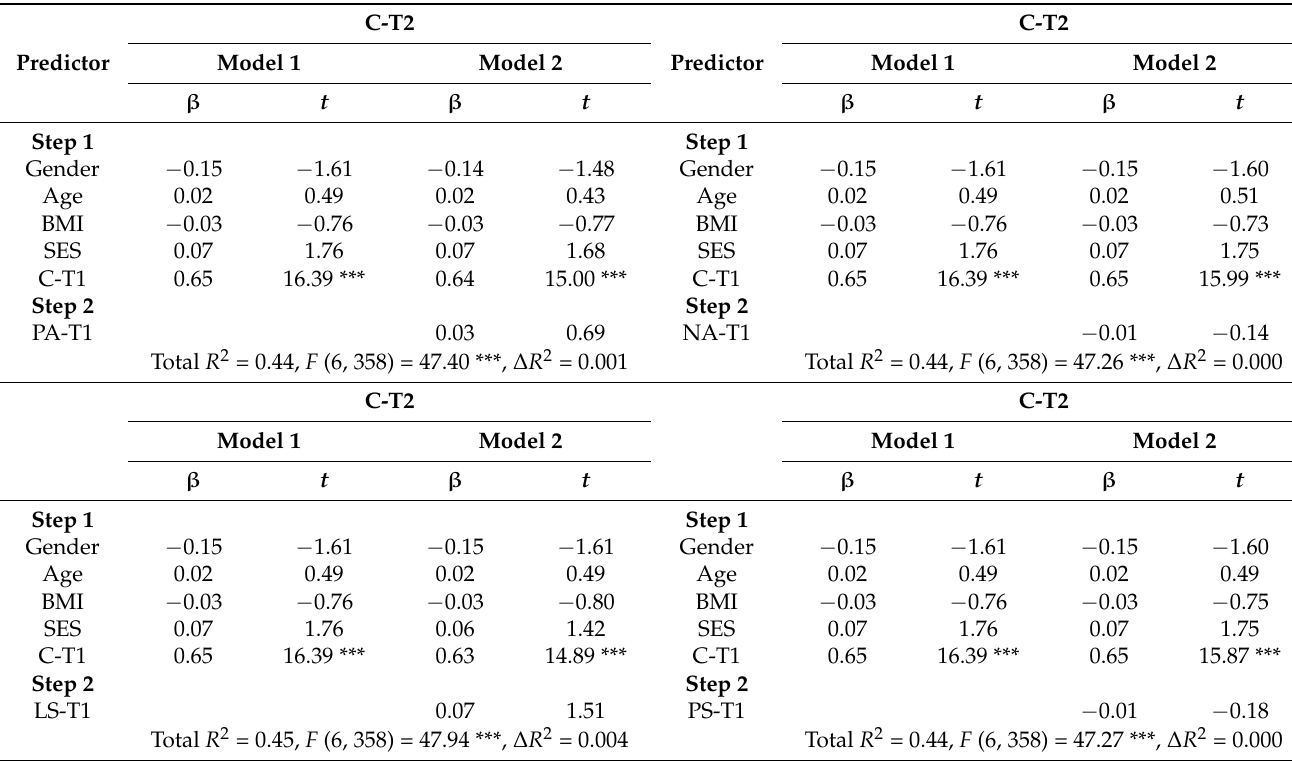
Table 4. Separate regression models for subjective and physical well-being at T1 predicting T2